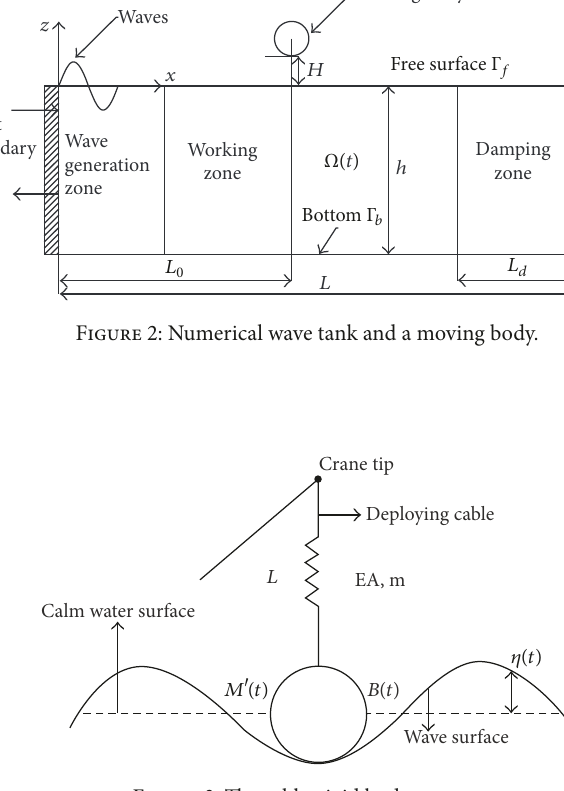
Figure 3: The cable-rigid body